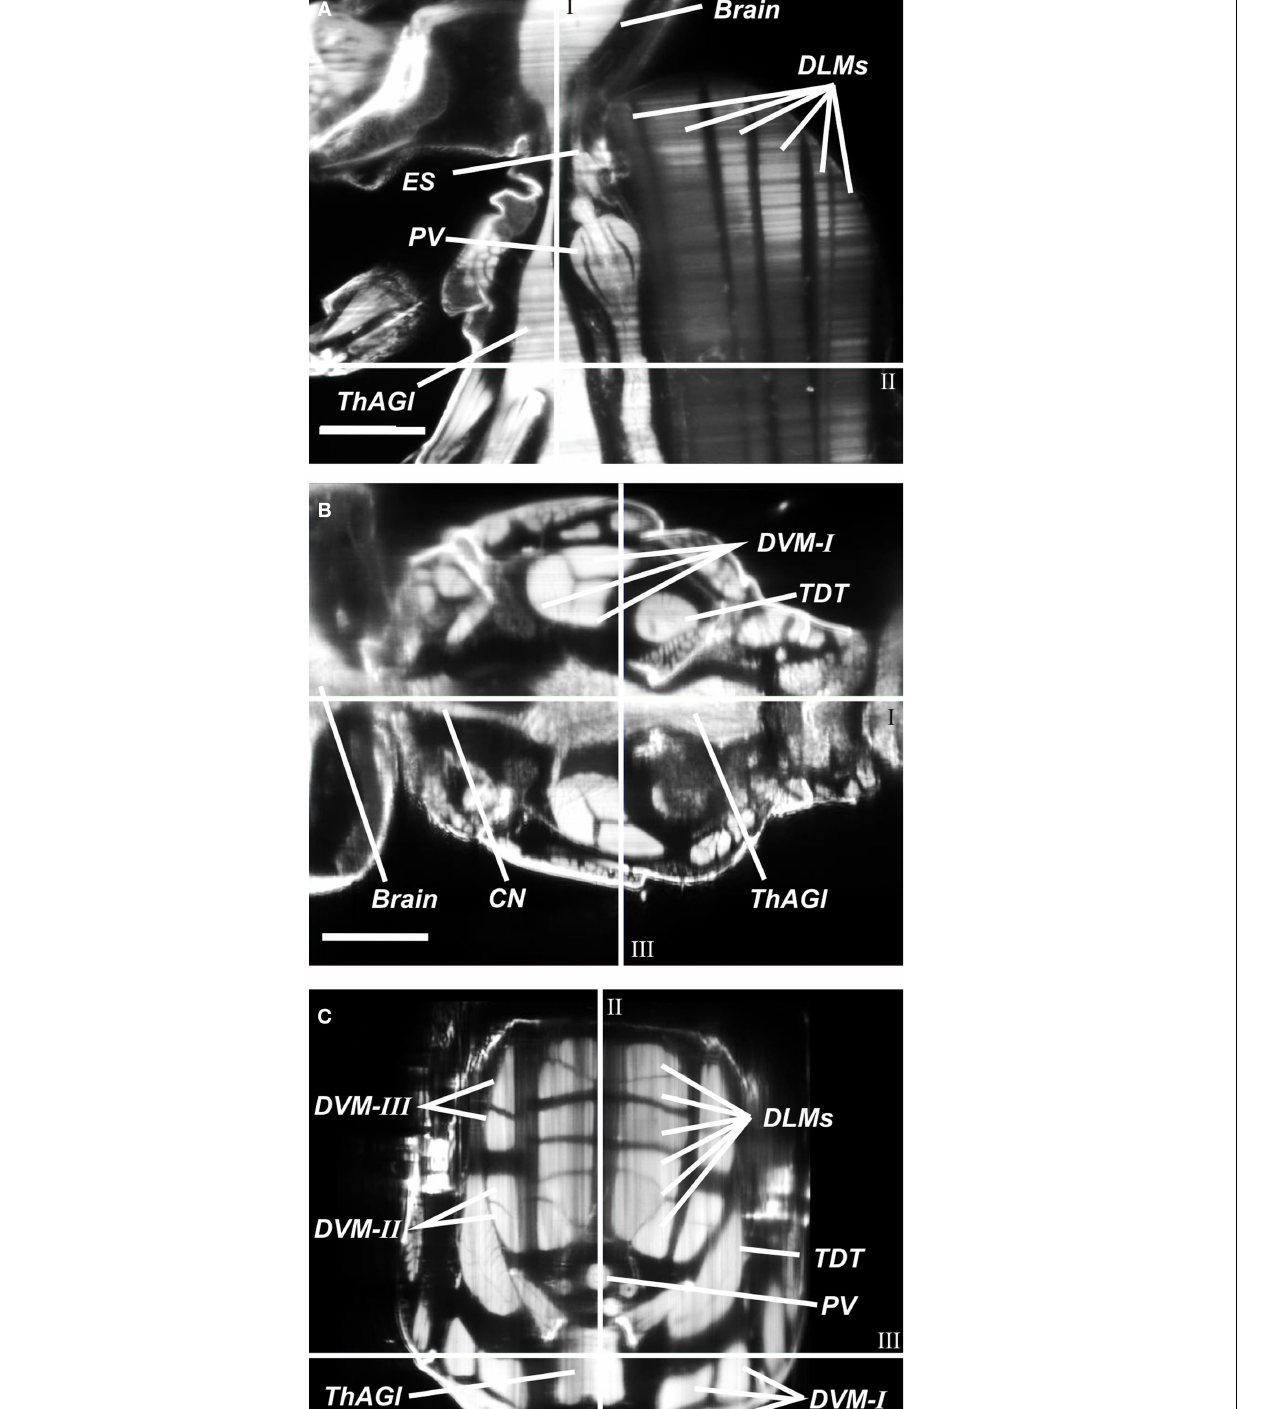
of the trochanter; ThAGl, thoracico-abdominal ganglion. I: Sagittal plane, II: transversal plane, III: coronal plane. (A) Sagittal optical slice. (B) Computed coronal slice. (C) Computed transversal slice. Length of scale bars 100